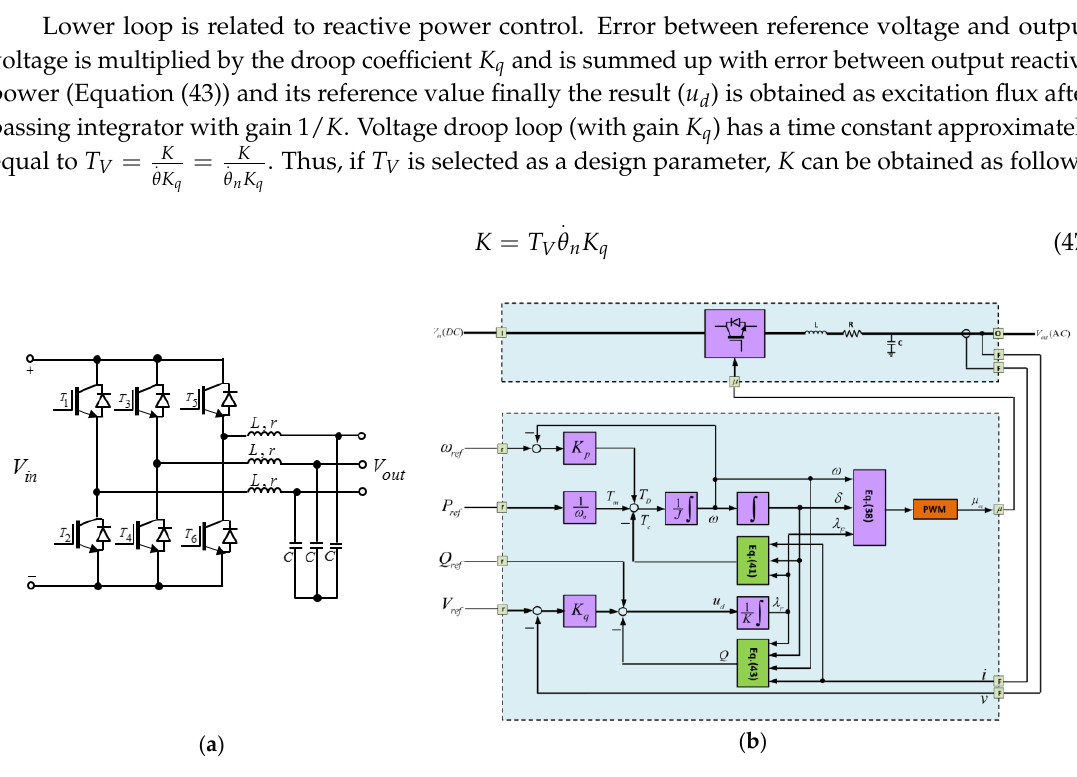
Figure 6. ( a ) Power circuit of DC/AC converter; ( b ) controller model of converter based on VISMA.